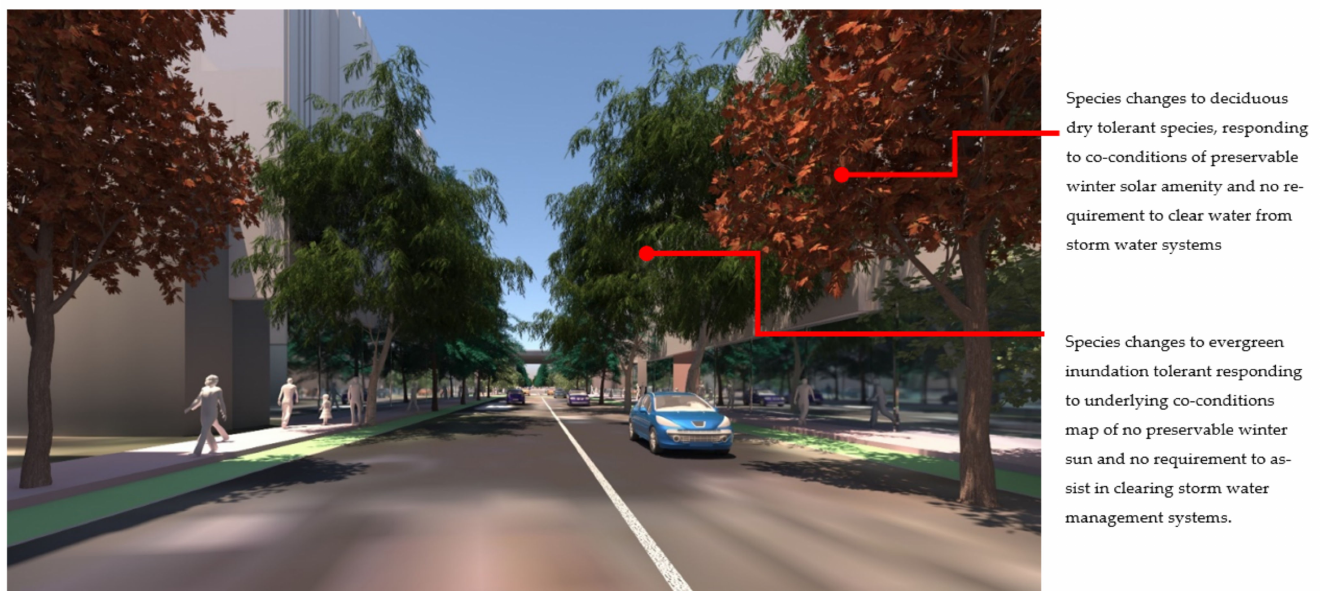
Figure 17. Macaulay Road view of Flood scenario (1) ‘land subject to inundation’ during dry weather. Several changes in tree species can be seen in the background responding to the underlying flood condition map, but with cross street symmetry. This image also shows the asymmetric tree positioning. Image by authors using multi-criteria street tree design decision support modelling approach in Autodesk™ 3ds Max™.